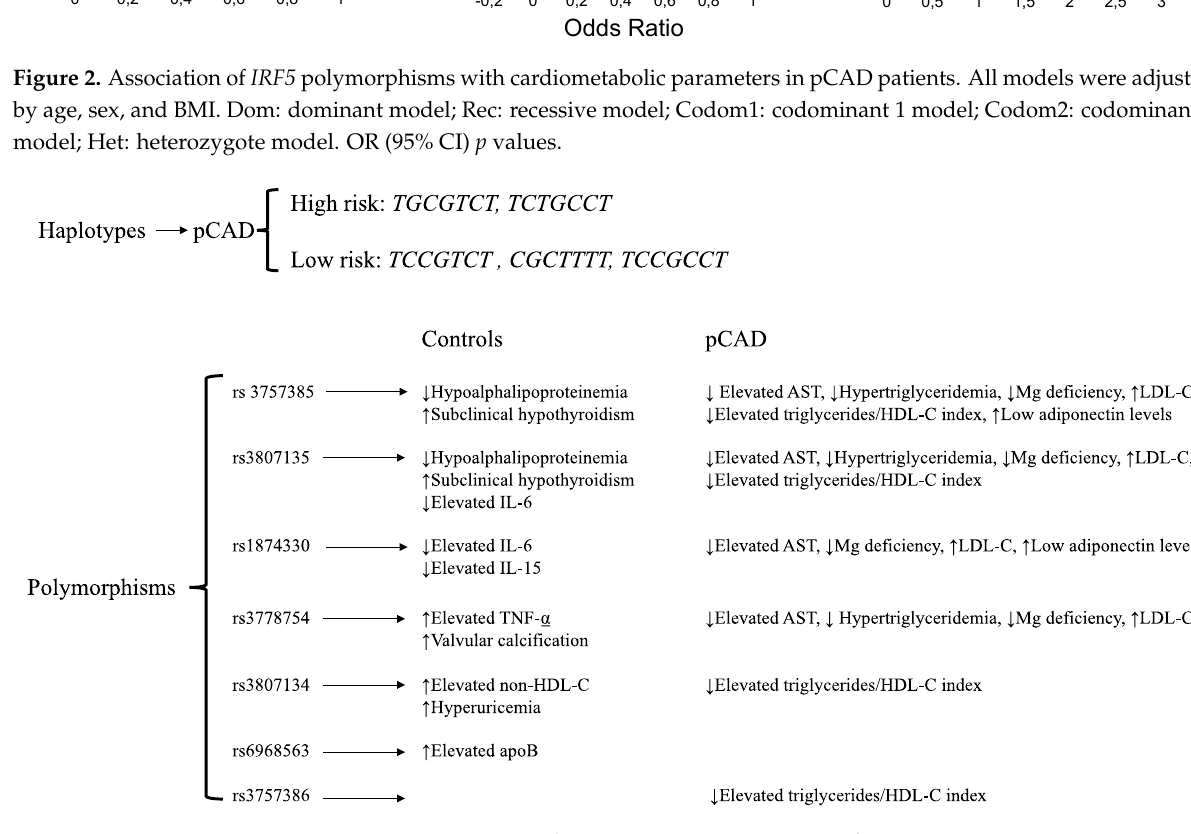
Figure 3. Summary results. AST: aspartate aminotransferase.